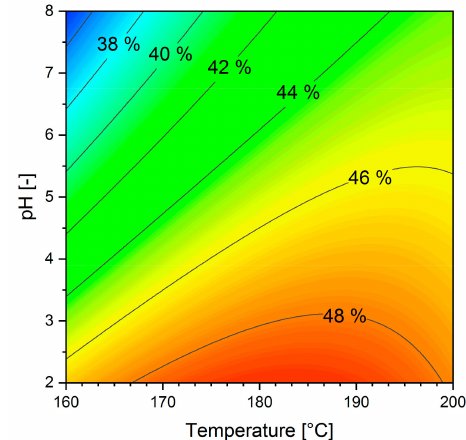
Figure 4. Regression model contour plot showing the influence of initial pH and reaction temperature on the dry matter content (%) after mechanical dewatering.